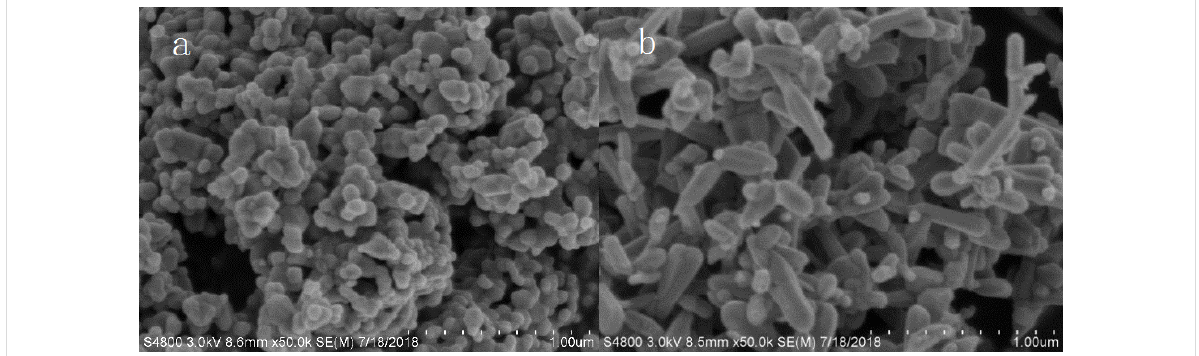
Figure 5: SEM micrographs of (a) ZnO and (b) CZO-4 (3% Ce doping).